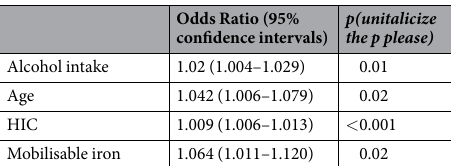
Table 4. Multivariable logistic regression analysis of factors associated with prediction of advanced fibrosis in all subjects with HH. Adjusted for serum ferritin and